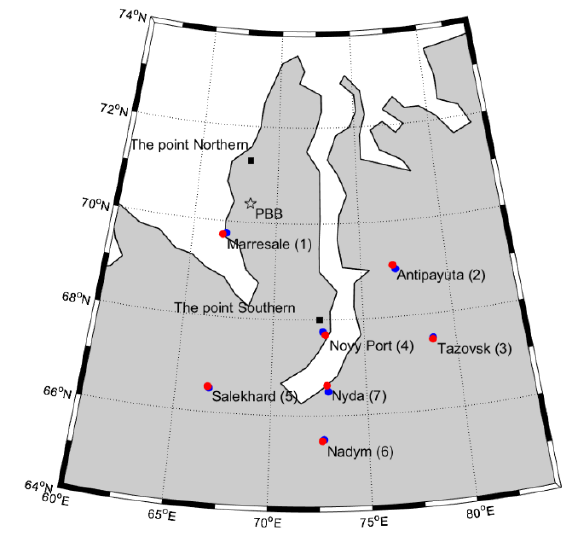
Figure 4. Meteorological stations ( red dots ) and nearest to them ERA5 reanalysis grid points ( blue dots ) used in the study. The black squares show the position of State Hydrological Institute measurements in 1985–1997, the star shows the position of State Hydrological Institute and Moscow State University measurements in 1990–1993.